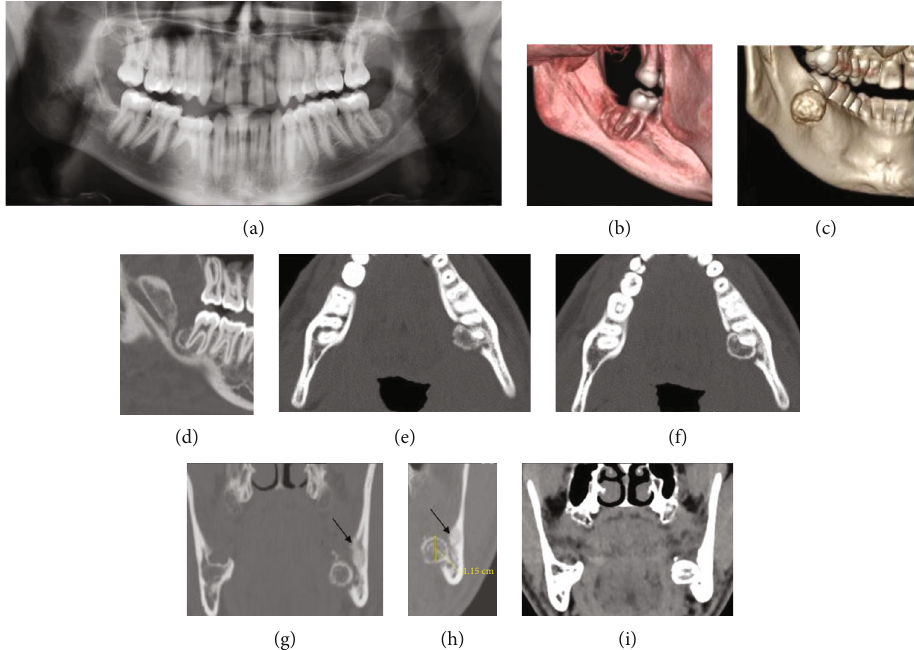
Figure 4: (a) Case #2 panoramic radiograph. (b and c) 3D CT reconstruction, viewed from the lingual aspect. (d) CBCT sagittal view. (e – f) Bone window CT axial views. (g – h) Bone window CT coronal views. (i) Soft tissue window CT coronal view. Panoramic radiograph was taken 8 months postsurgical extraction of the impacted tooth #17. An exophytic mixed density lesion, measuring 1 : 2 × 1 : 0 × 1 : 1 cm, emanated from the distal root of tooth #18. The border of the lesion is well-demarcated with a sclerotic rim surrounded by a lucent rim. Small area of bony sclerosis is noted at buccal and superior of the lesion (arrows) (g and h). There was no evidence of root resorption at associated root of #18. Unlike case 1, there is no evidence of expansion, new bone formation, or adjacent soft tissue edema (i).